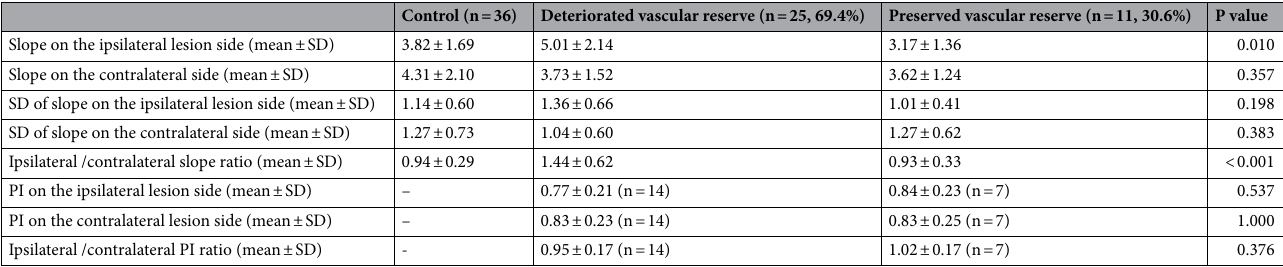
Table 2. The value of slope of oxyhemoglobin wave according to cerebral perfusion. SD standard deviation; PI pulsatility index. Unit = Fs·10–4 mM/sec; Fs = 8.138 Hz.